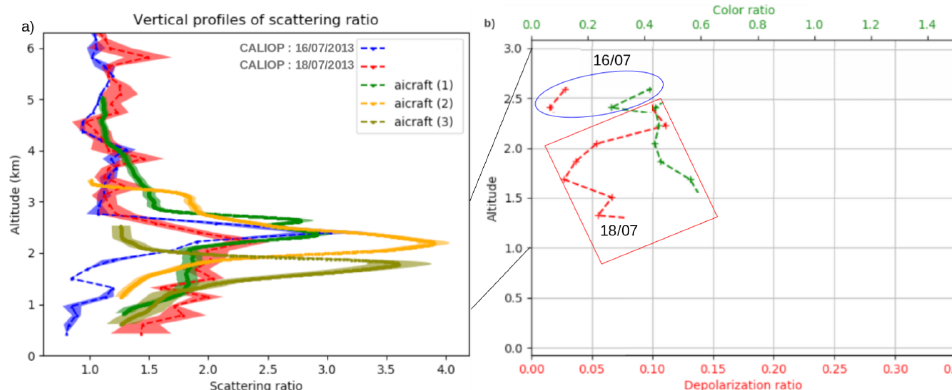
Figure 13. ( a ) Vertical profiles of 532 nm backscatter ratio for the aircraft lidar in red box of Figure 11a (red line) and for CALIOP on 16 and 18 July 2013 at, respectively 19 UT, 62 ◦ N and 05 UT, 59 ◦ N. ( b ) Vertical profiles of the particle color ratio (green) and particle linear depolarization ratio (red) measured by